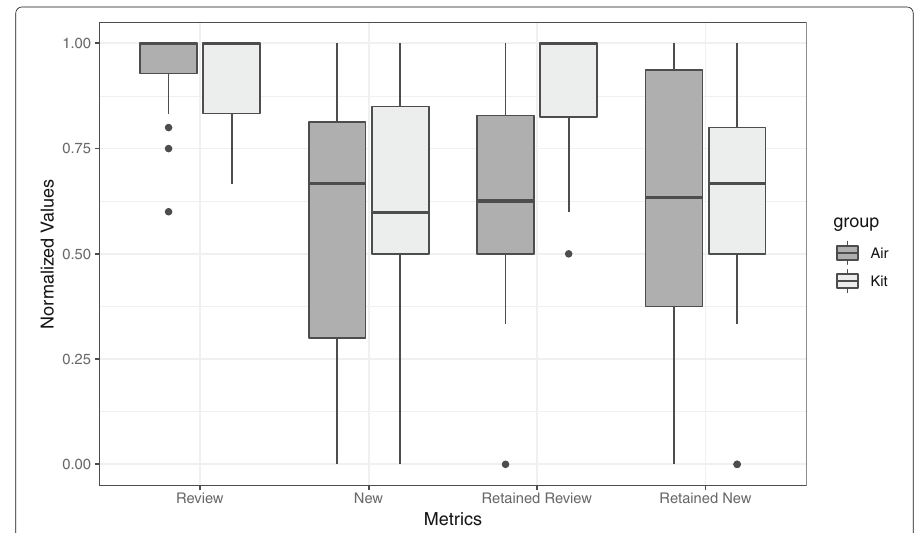
Fig. 3 Boxplots of the normalized values for Air and Kit conditions. Retained review, which is related to retained reviewed knowledge, represents the biggest difference between the two conditions